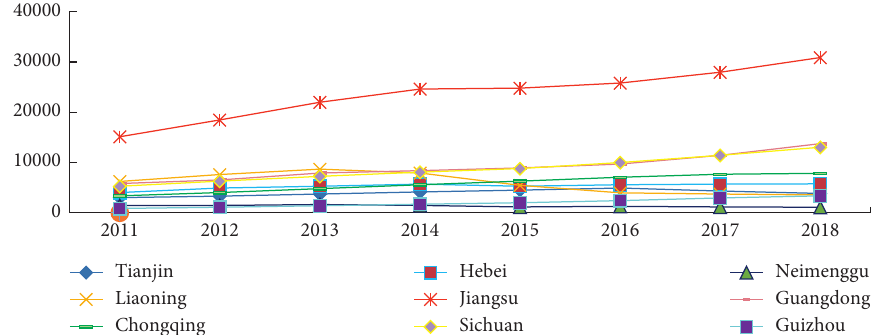
Figure 4: Changes in building output value in abnormal